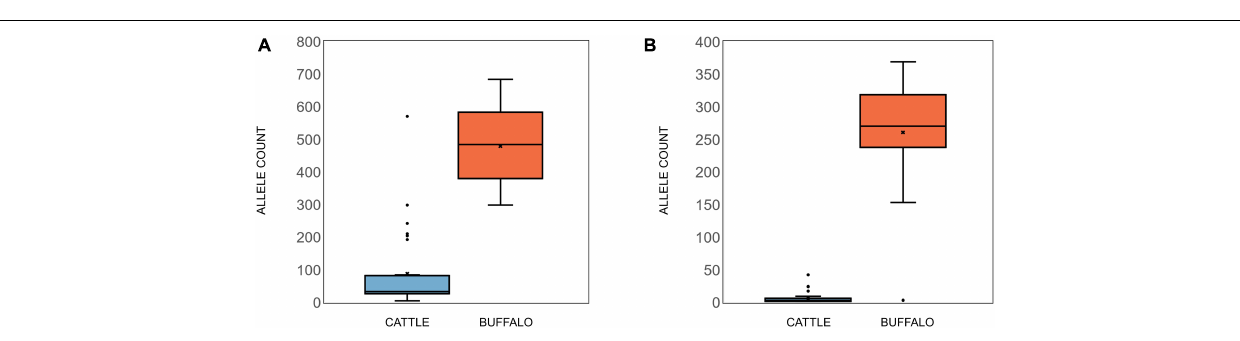
FIGURE 7 | (A) Tp4 and (B) Tp16 allele counts in cattle (blue) and buffalo (orange). Median (line), mean (x), and standard deviation (whiskers) are